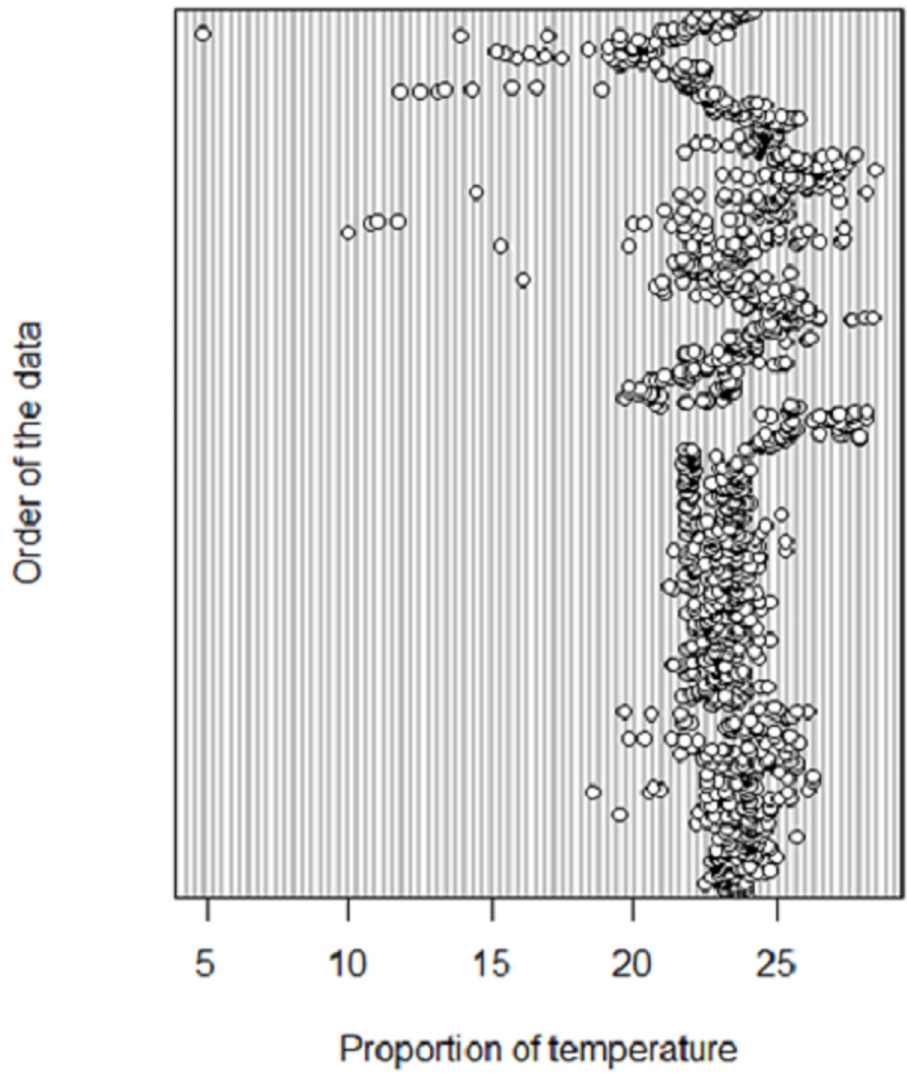
temperature figures or